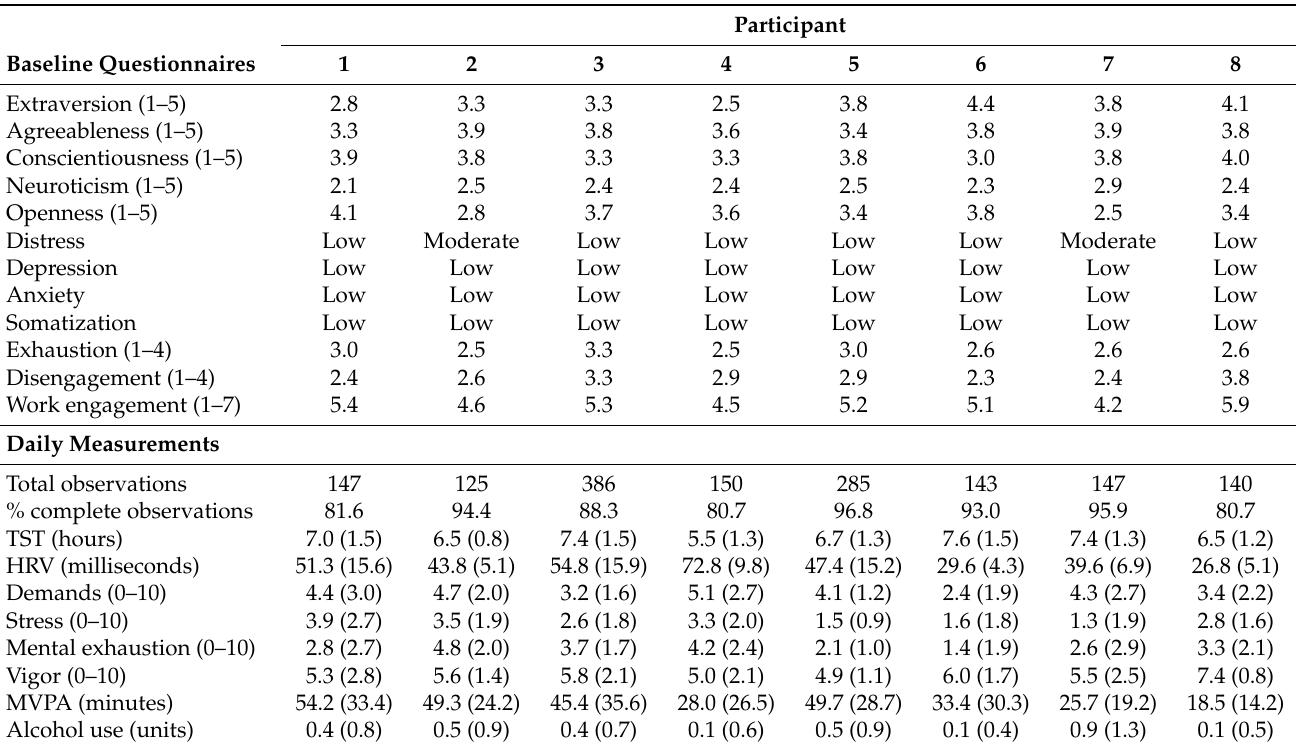
Table 1. Participant